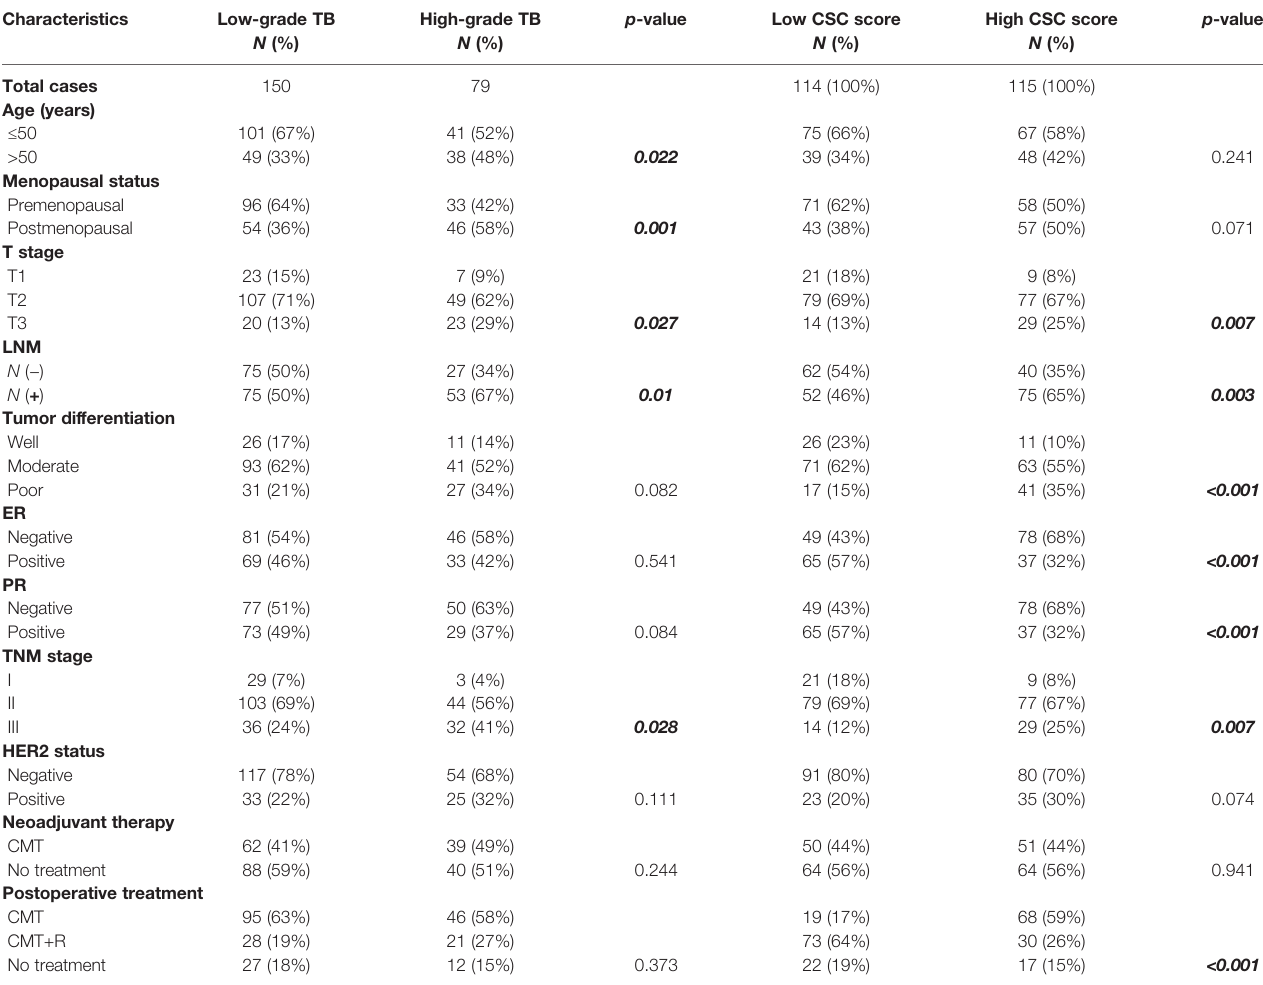
TABLE 2 | The relationship between TB, CSC score, and major clinicopathological characteristics of BC patients. Characteristics